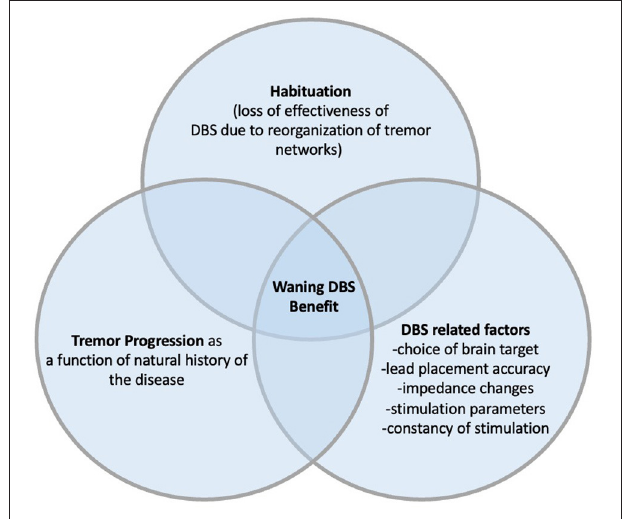
FIGURE 1 | Factors contributing to decline in clinical benefit of tremor after